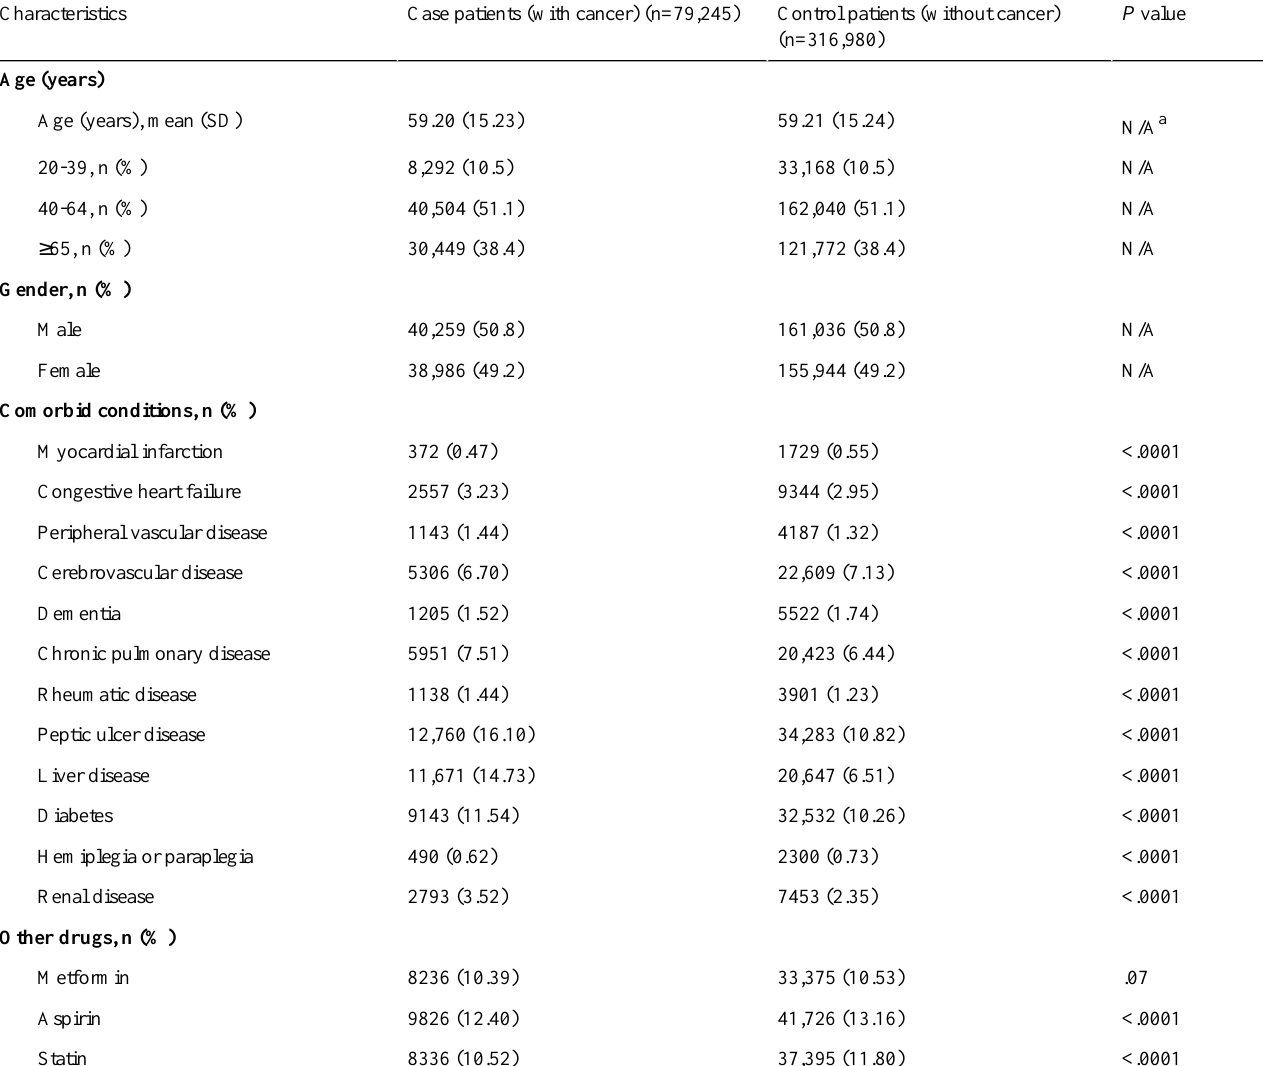
Table 2. Baseline characteristics of case patients and control